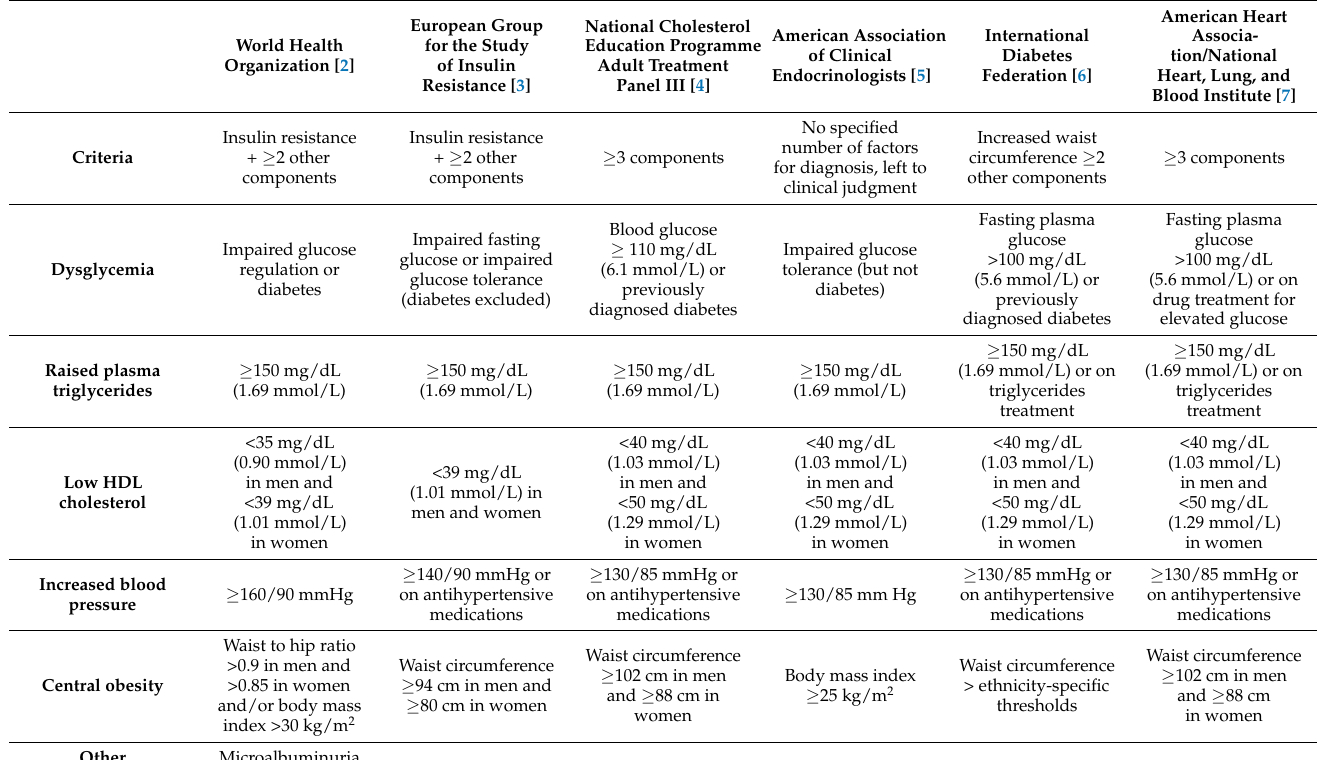
Table 1. Criteria for the diagnosis of metabolic